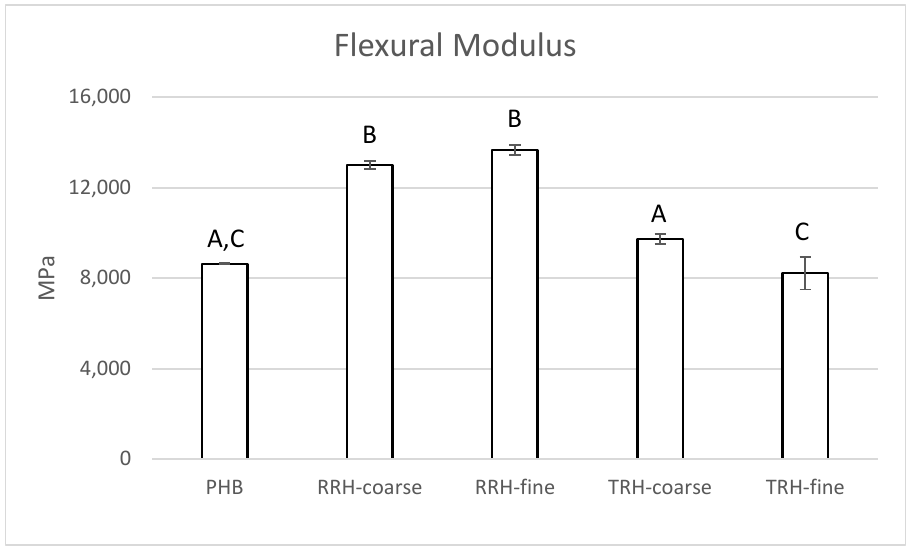
Figure 7. Stress–strain curves for flexural tests of PHB, PHB with 10% coarse RRH, PHB with 10% fine RRH, PHB with 10% coarse TRH, and PHB with 10% fine TRH composite samples.